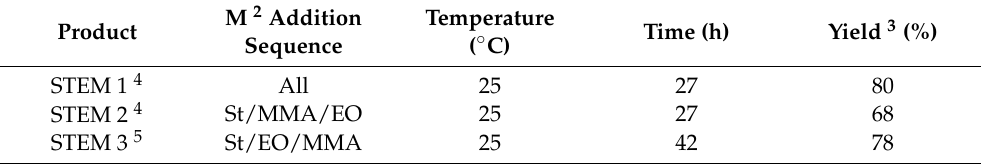
Table 1. Influence of the copolymerization conditions 1 on the copolymer